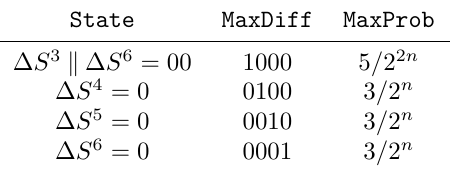
. enc , ∆ M [1 .. 4] = 1000, enc